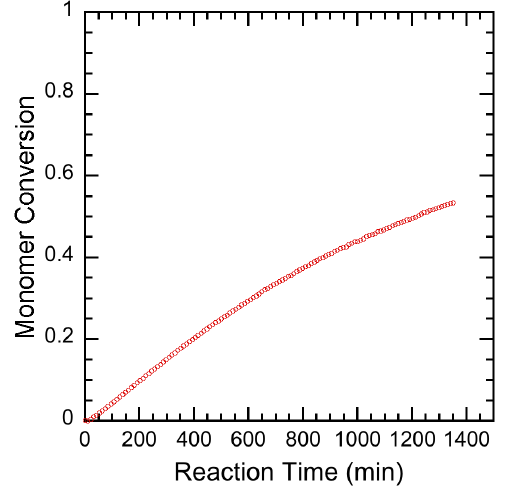
Figure 5. Polymerization kinetics (monomer conversion) of PMMA-3 as determined by in situ 1 H NMR